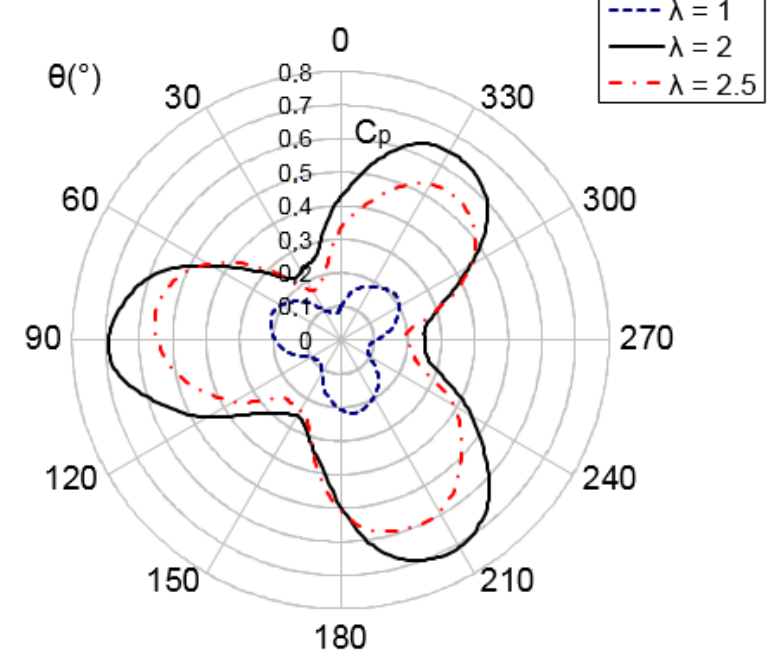
Figure 8. Instantaneous power coefficient of the URANS model when λ = 1, λ = 2, λ = 2.5.